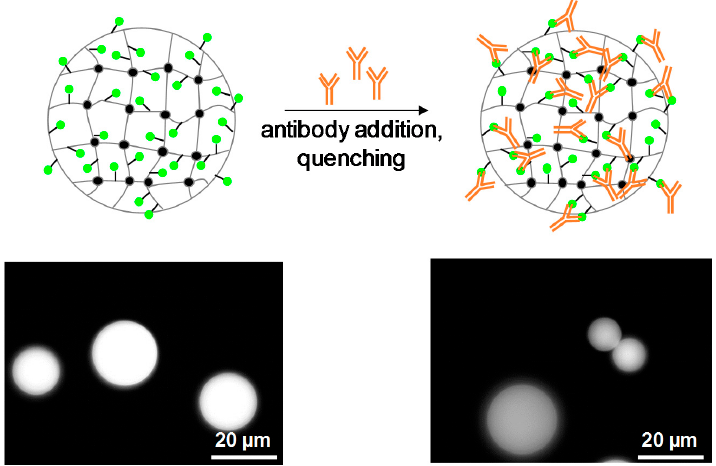
Figure 3. Fluorescence microscopy of BSA-FITC SCPs without addition of antibodies ( left ) and after addition of antibodies ( right ). Reduction on fluorescence intensity is due to quenching upon antibody binding and signifies specific interaction of the antibody with the SCPs.